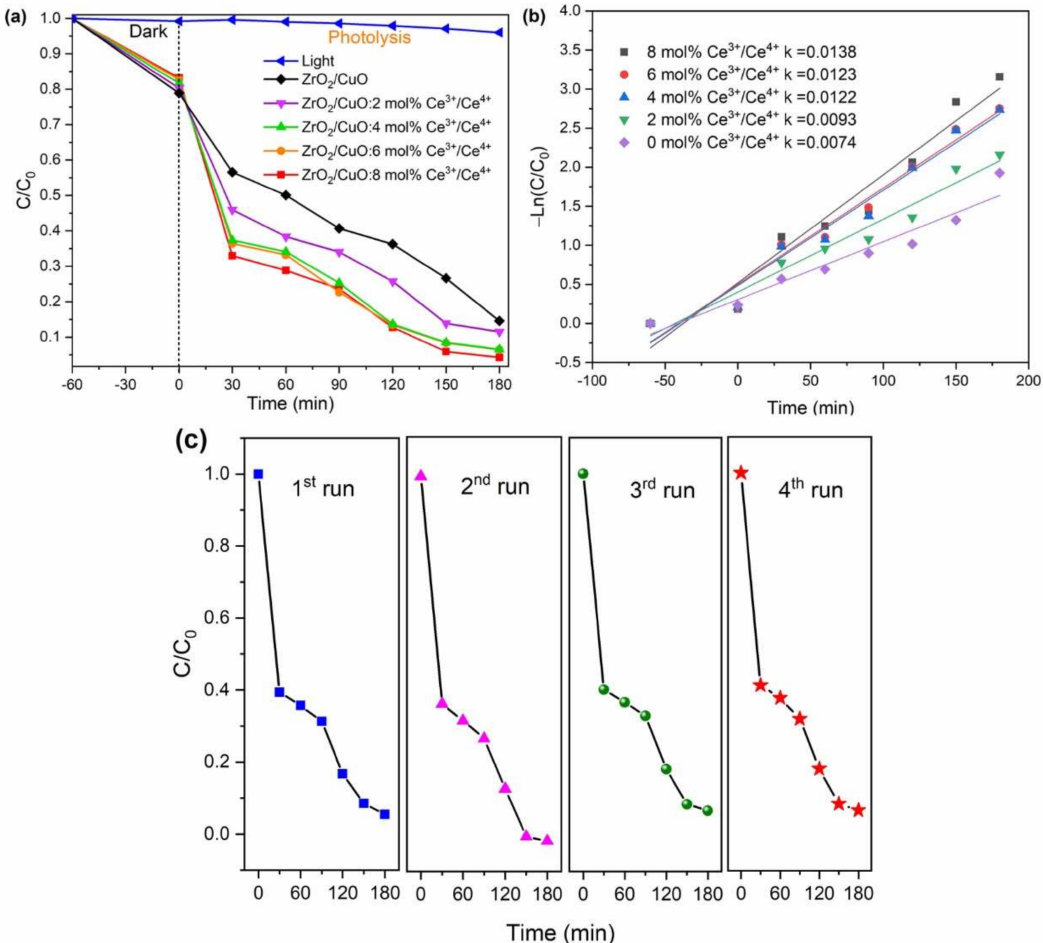
Figure 9. ( a ) Photodegradation of MB, ( b ) the reaction rate constant k of the MB degradation in the presence of x mol% Ce 3+ /Ce 4+ doped ZrO 2 /CuO (x = 0; 2; 4; 6; 8), ( c ) reuse of 8 mol% of Ce 3+ /Ce 4+ doping ZrO 2